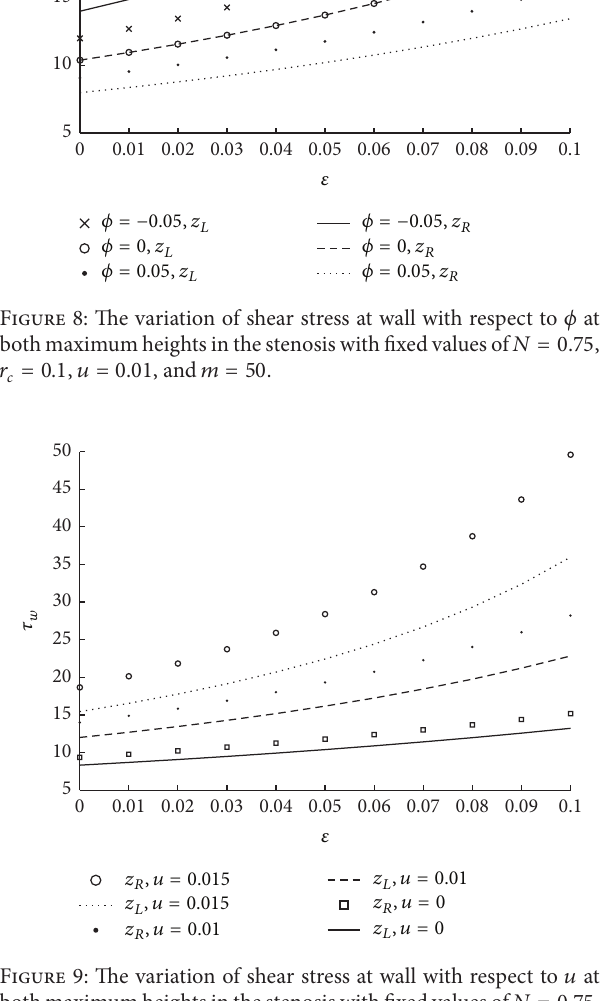
Figure 9: The variation of shear stress at wall with respect to 𝑢 at both maximum heights in the stenosis with fixed values of 𝑁 = 0.75 , = 0.1 , 𝜙 = −0.05 , and 𝑚 = 50 𝑟 𝑐